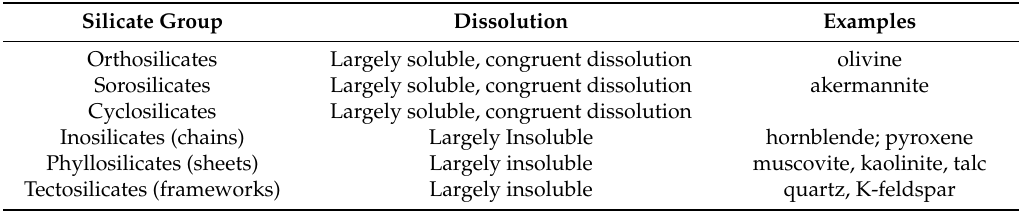
Table 2. Silicate types, based on structure, and general dissolution behaviour in acid